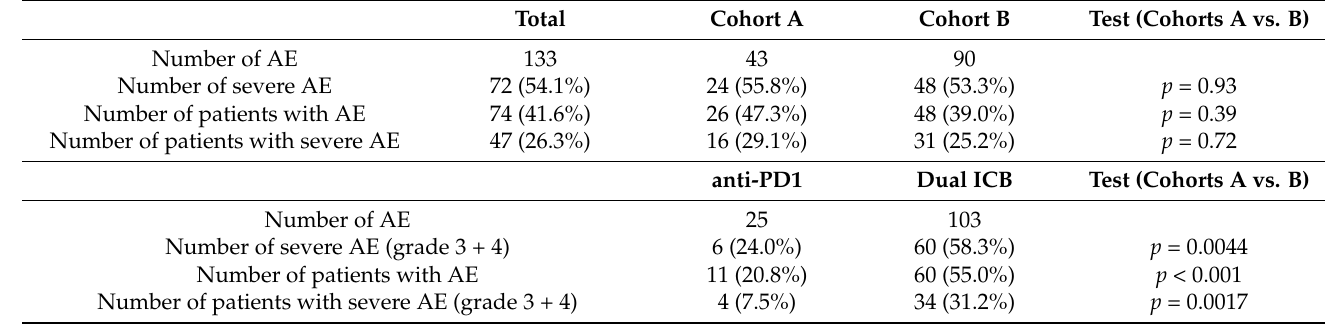
Table 3. Occurrence of adverse events. Abbreviations: AE = adverse